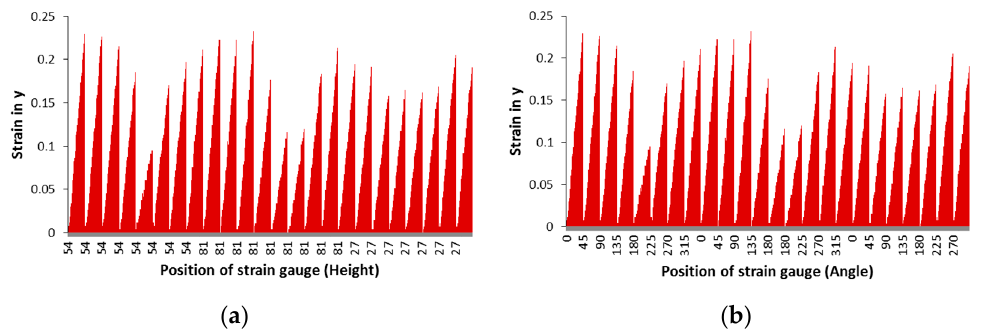
Figure 5. ( a ) Variation of strain (Height) and ( b ) variation of strain (angle) in 𝑦 direction.